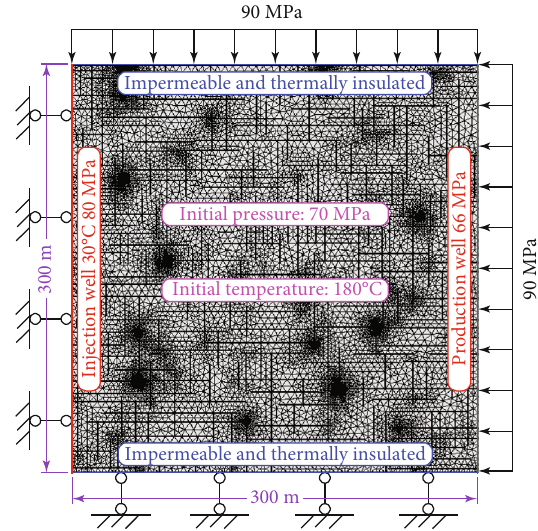
Figure 2: FEM mesh model of the geothermal reservoir with initial and boundary